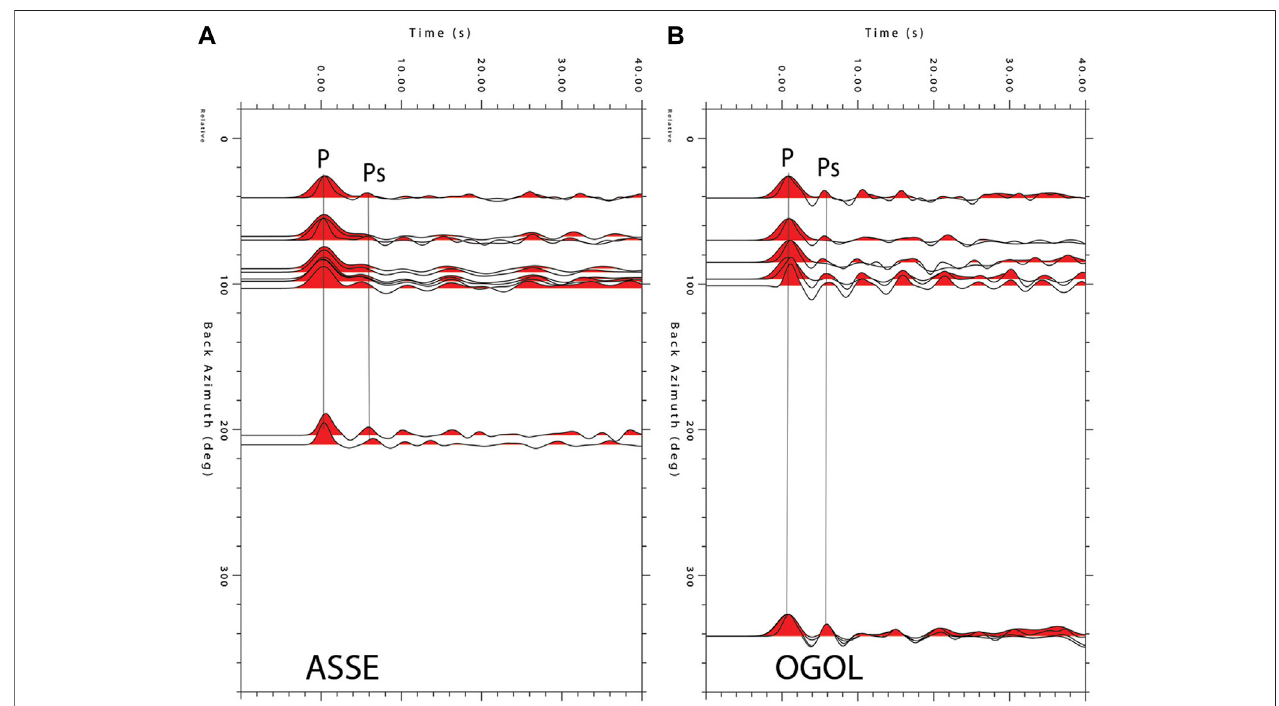
FIGURE 4 | (A) and (B) are examples of RFs calculated for signals coming from different azimuths. Positive values were fi lled with red ink to emphasize prominent features, such as the direct P and the Ps phase, which is the P-to-S conversion.